Question: Which kind of chart has been used to present this data?
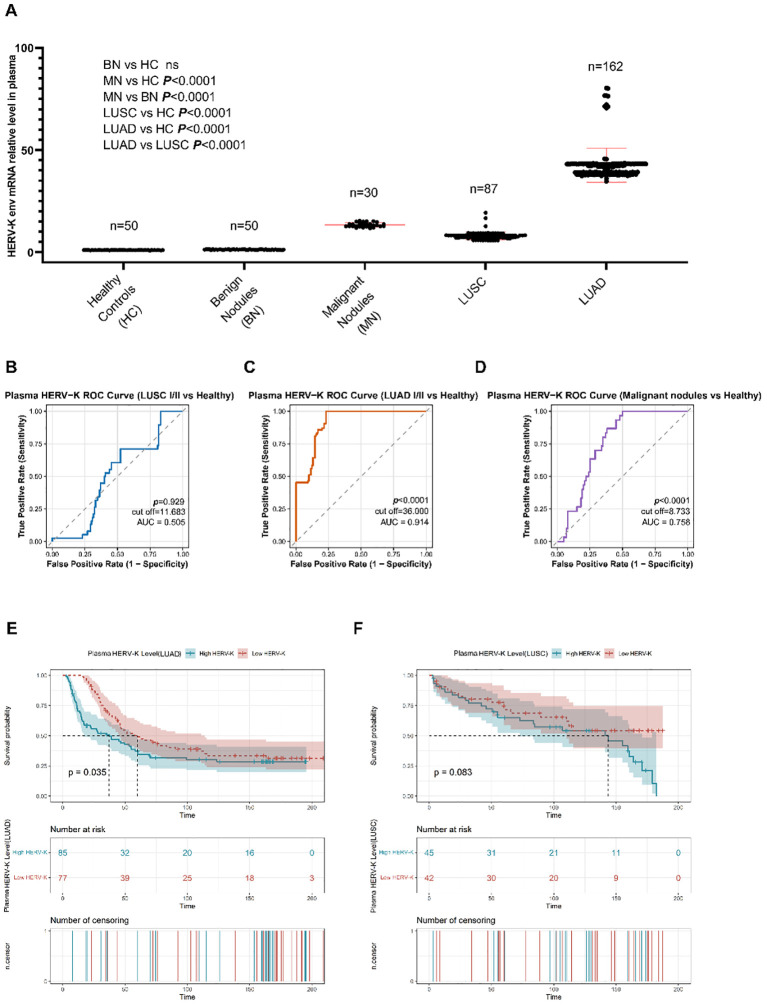
Answer: survival